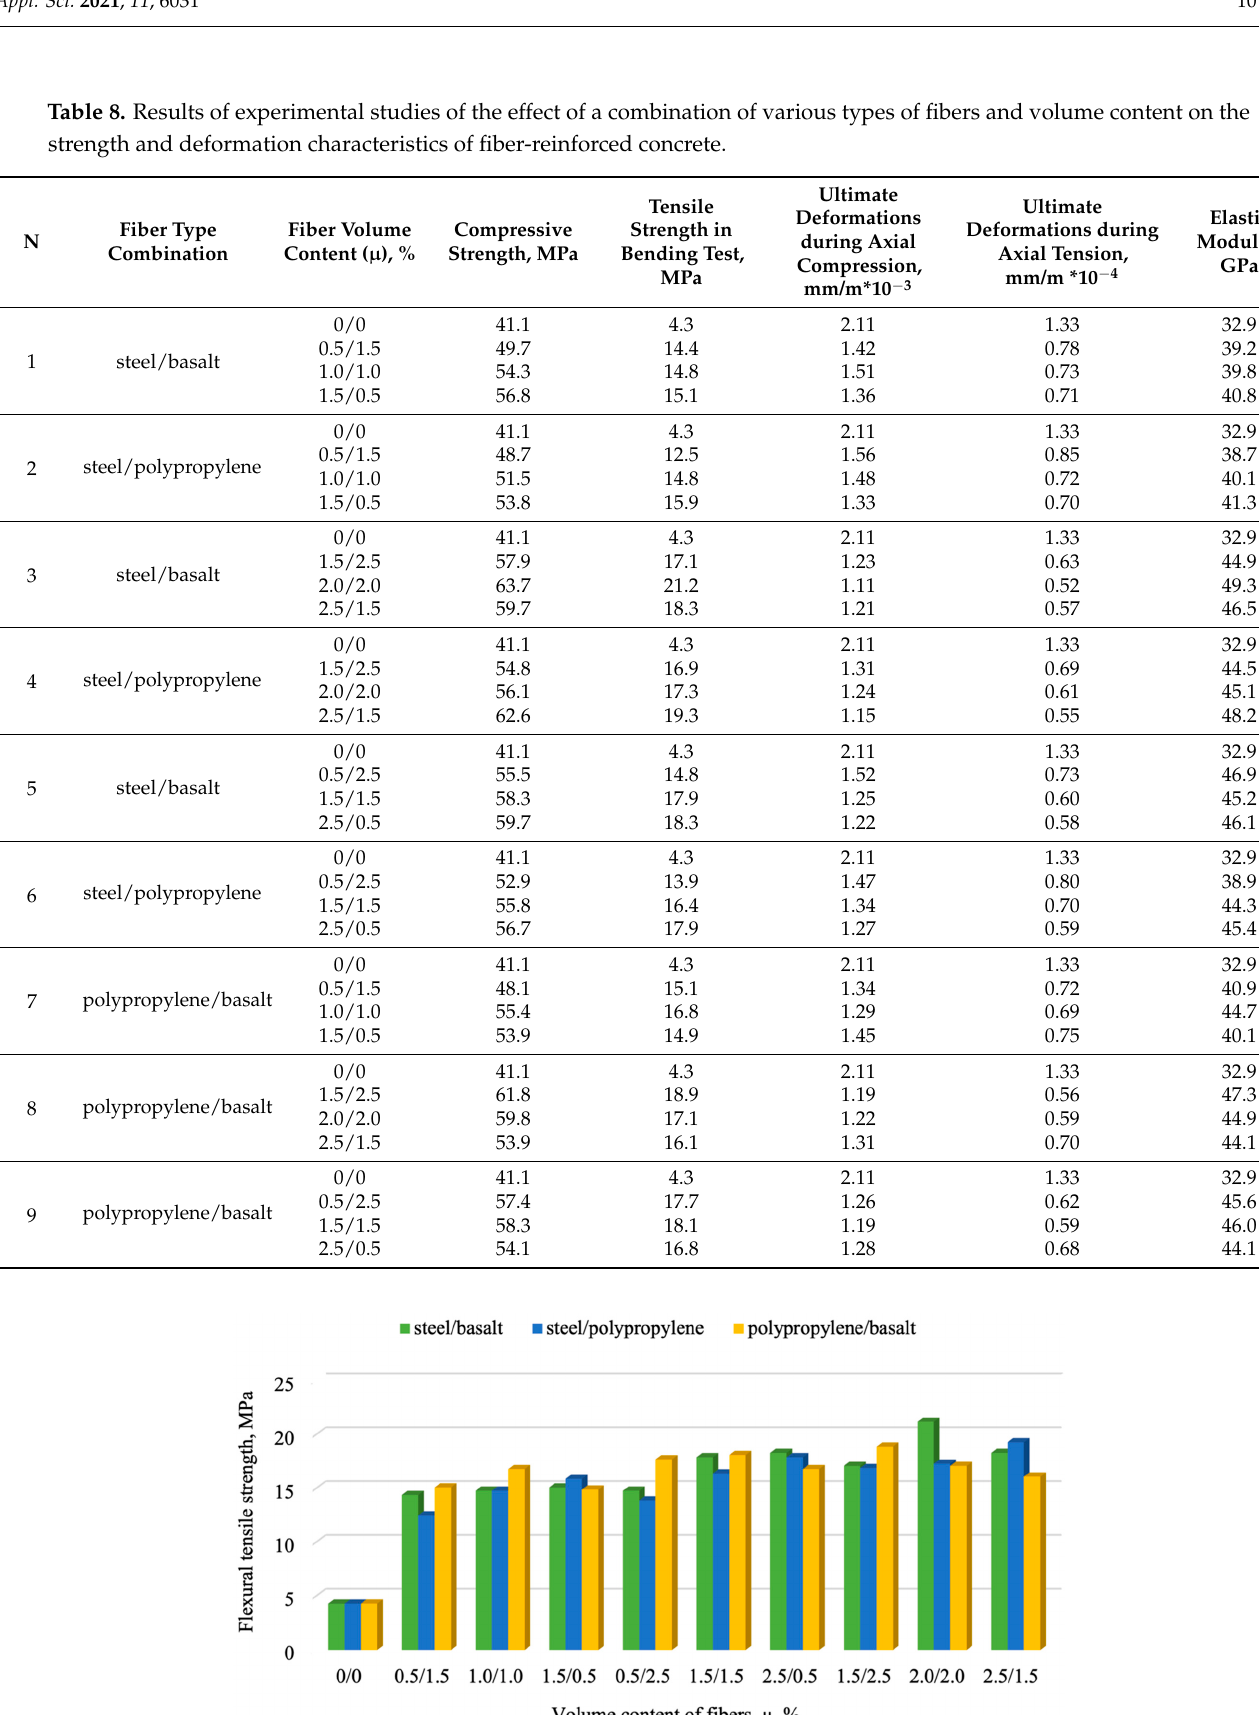
Figure 9. Dependence of the ultimate deformations of fiber-reinforced concrete under axial compression on the type of fiber combination and volume content.